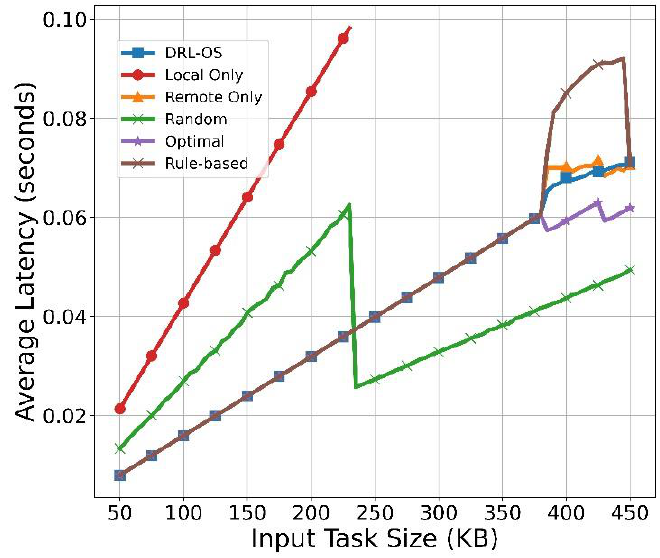
Figure 11. Average latency vs. input task size.